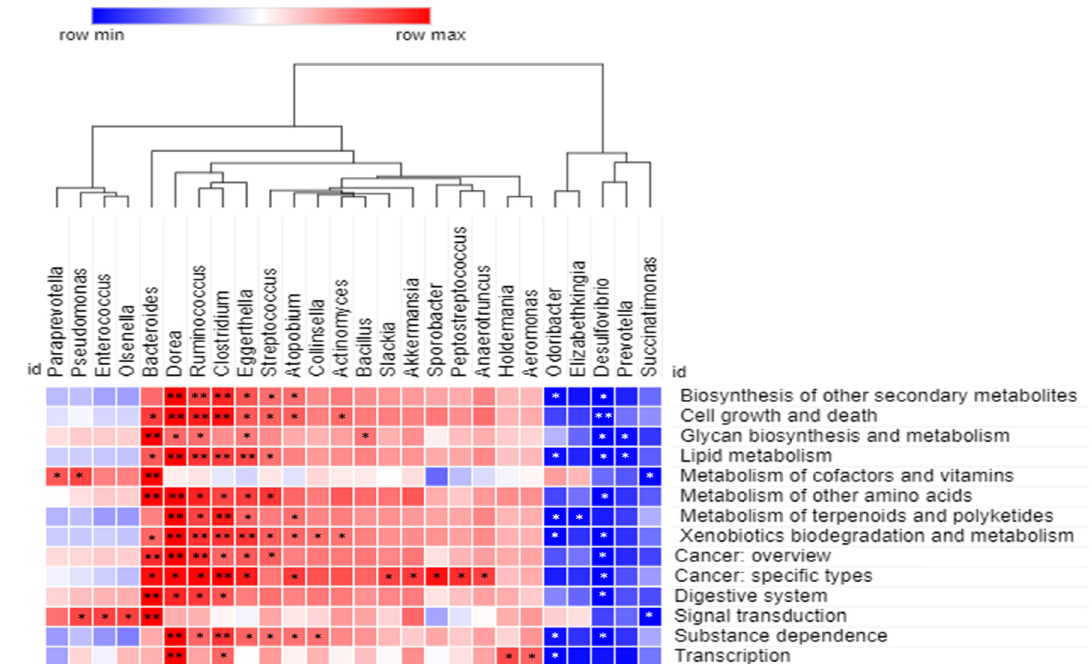
Figure 6. Correlations between the bacterial experimental groups community and predicted functional profiles, based on 16S rRNA amplicon sequencing. Spearman correlation analysis heatmap constructed for each pairwise comparison between level 2 Kyoto Encyclopedia of Genes and Genomes (KEGG) pathways and bacterial taxa at the genus level. The positive and negative correlations are indicated in red and blue colors, respectively. The correlation was considered significant at ** p < 0.01 and * p < 0.05.